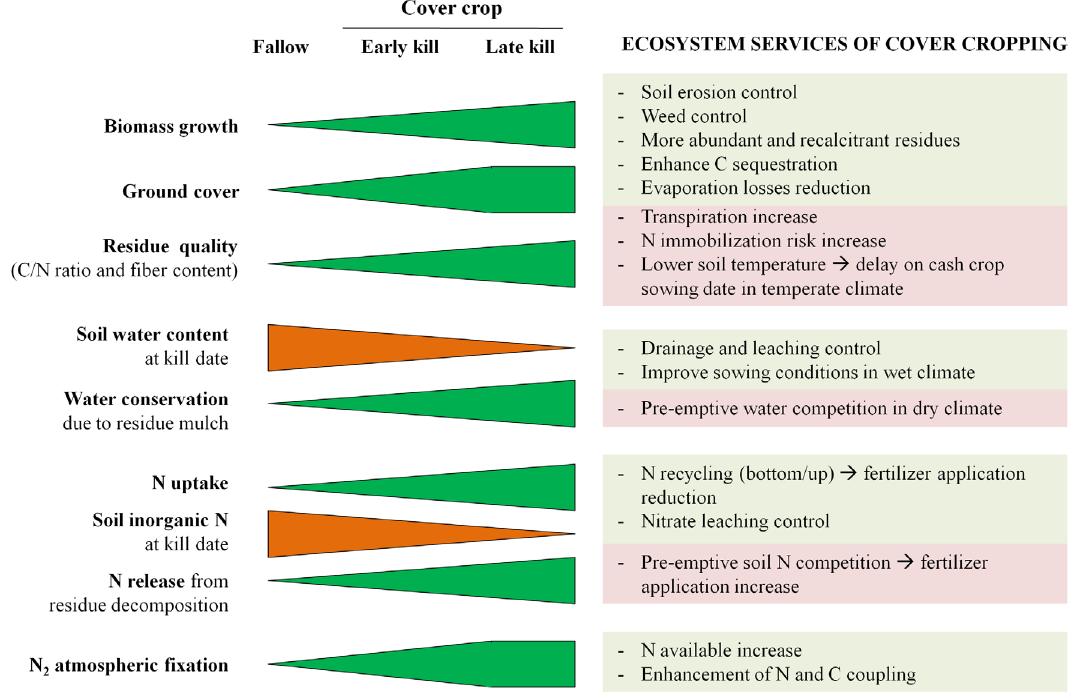
Figure 8. Schematic representation of the effect of kill date on environmental variables and ecosystem services with fallow as a reference condition.